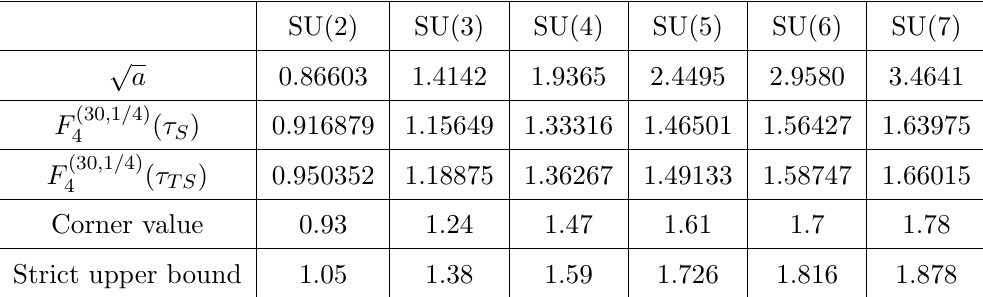
Figure 4 . A similar plot as (cid:12)gure 3 for (cid:18) = (cid:25) . The interpolating function F (30 ; 1 = 4) for the spin-0 operator is plotted as a function of g together with the 4-loop result. Note that p 3 corresponds to (cid:28) = (cid:28) TS = e i(cid:25)= 3 . g = 2 =